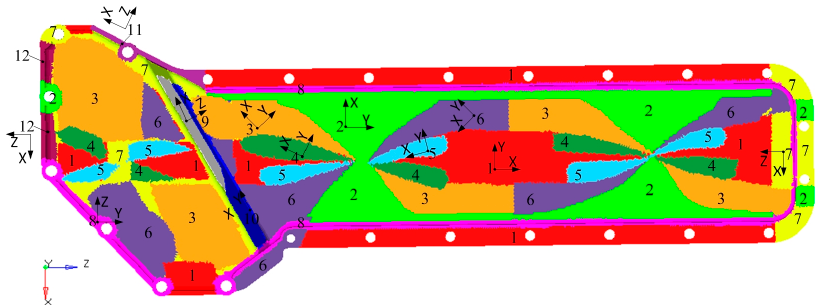
Figure 12. FE models with different material properties. The different numbers indicate the different groups and the different groups have the corresponding colors. The blocks with the same number and the same color are in the same group.